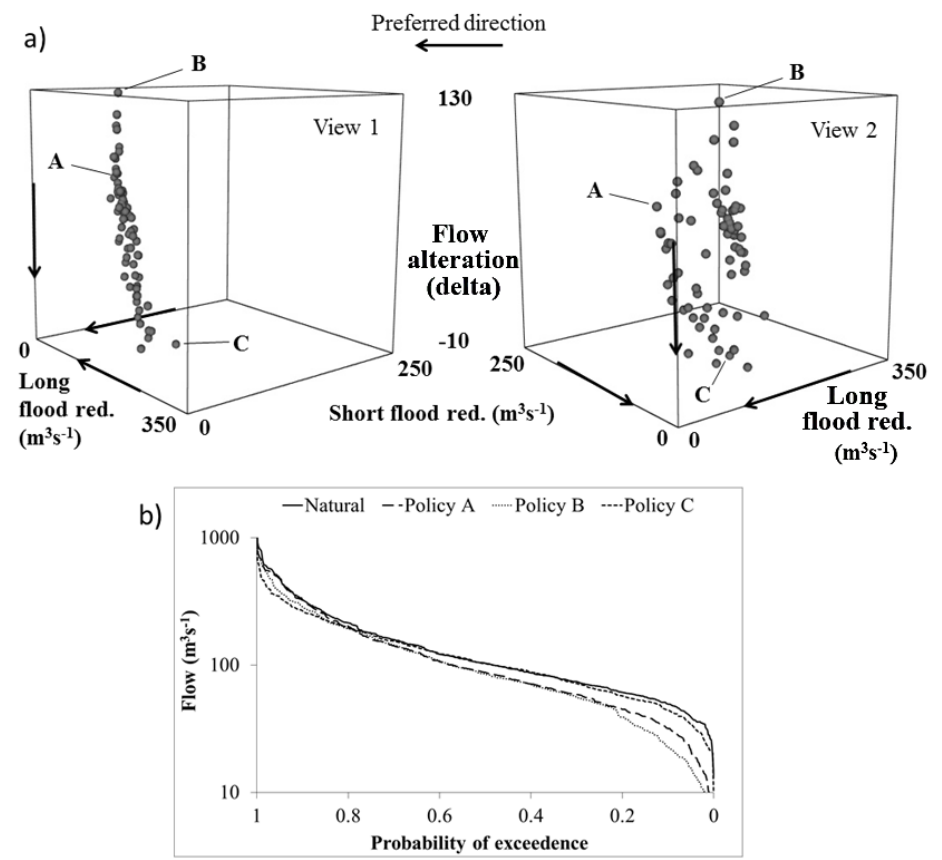
Figure 3. (a) Two views of the trade-off surface between flow-related objectives. Flow regime alteration decreases as flood peaks are reduced, allowing lower flows to be maintained closer to the natural regime. Three policies are highlighted and referred to in the text and subsequent figures. A 3-D animation of this plot is available in online supplementary material. (b) Comparison of the flow duration curves resulting from policies A, B and C in (a) . Policy C allows around 20% of highest flows to diverge from the natural curve to augment lower flows, maintaining them closer to the natural regime. Policy A achieves the